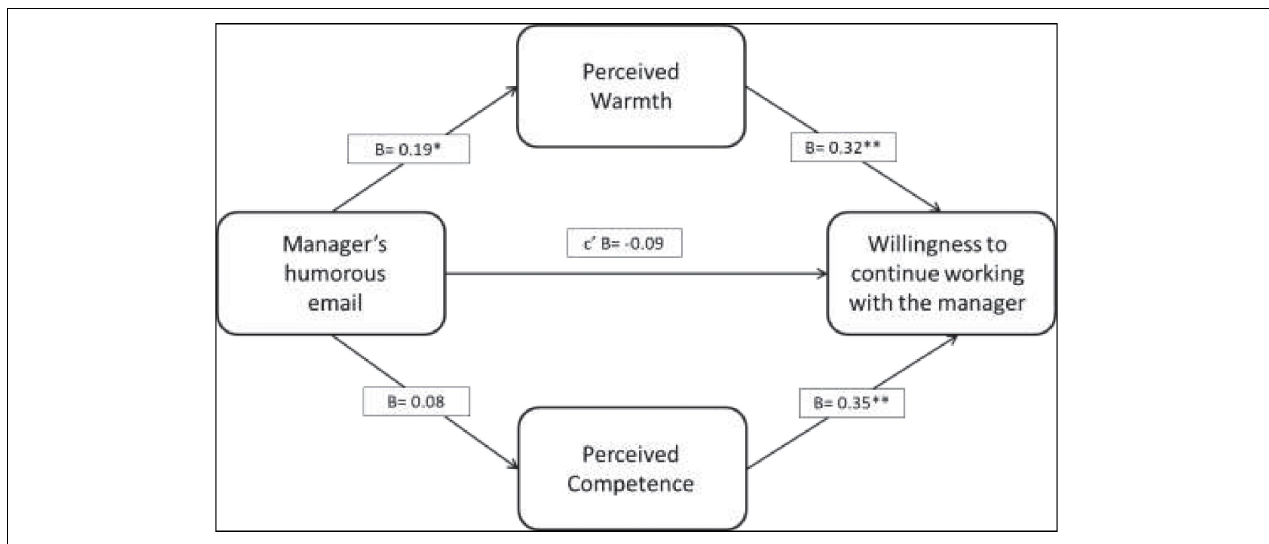
FIGURE 1 | The mediation model for Study 1 with unstandardized coefficients. Both mediators were tested simultaneously (Model 4, Hayes, 2017).